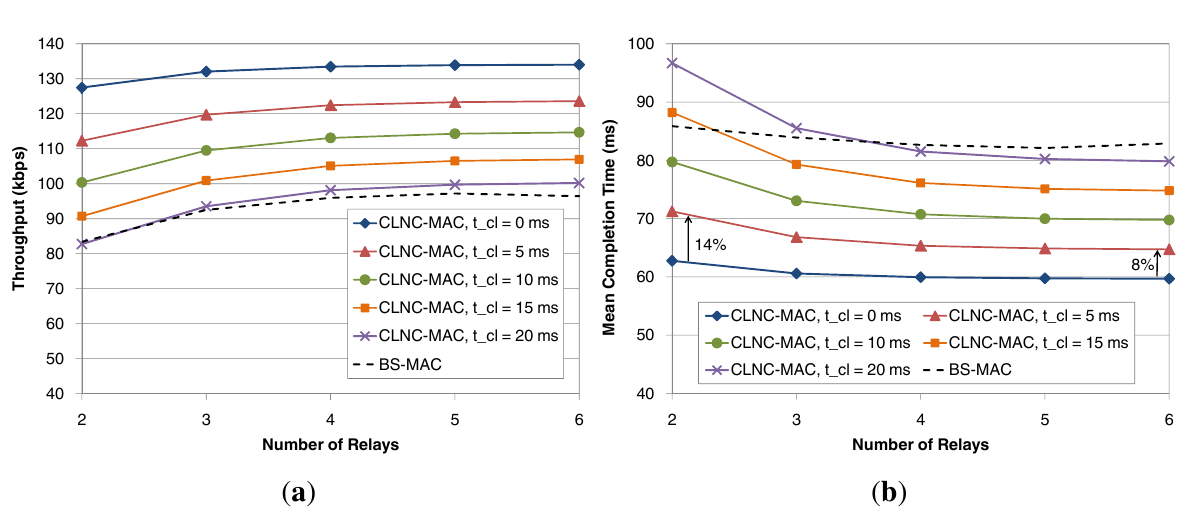
Figure 11. Impact of the cloud communication time on the performance of CLNC-MAC. ( a ) Throughput; ( b ) mean data